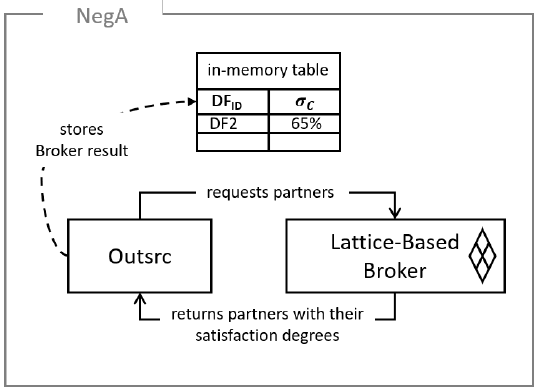
Figure 4. The interactions among the NegA, Outsrc, and Broker.